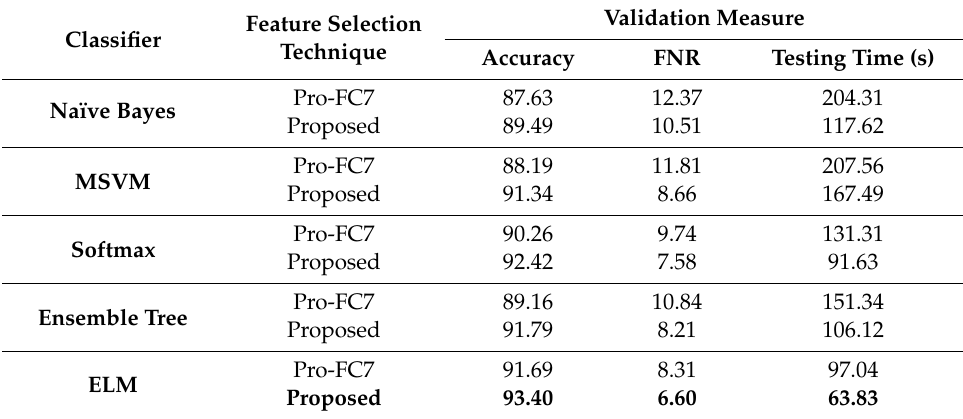
Table 7. Classification results for the BraTS 2018